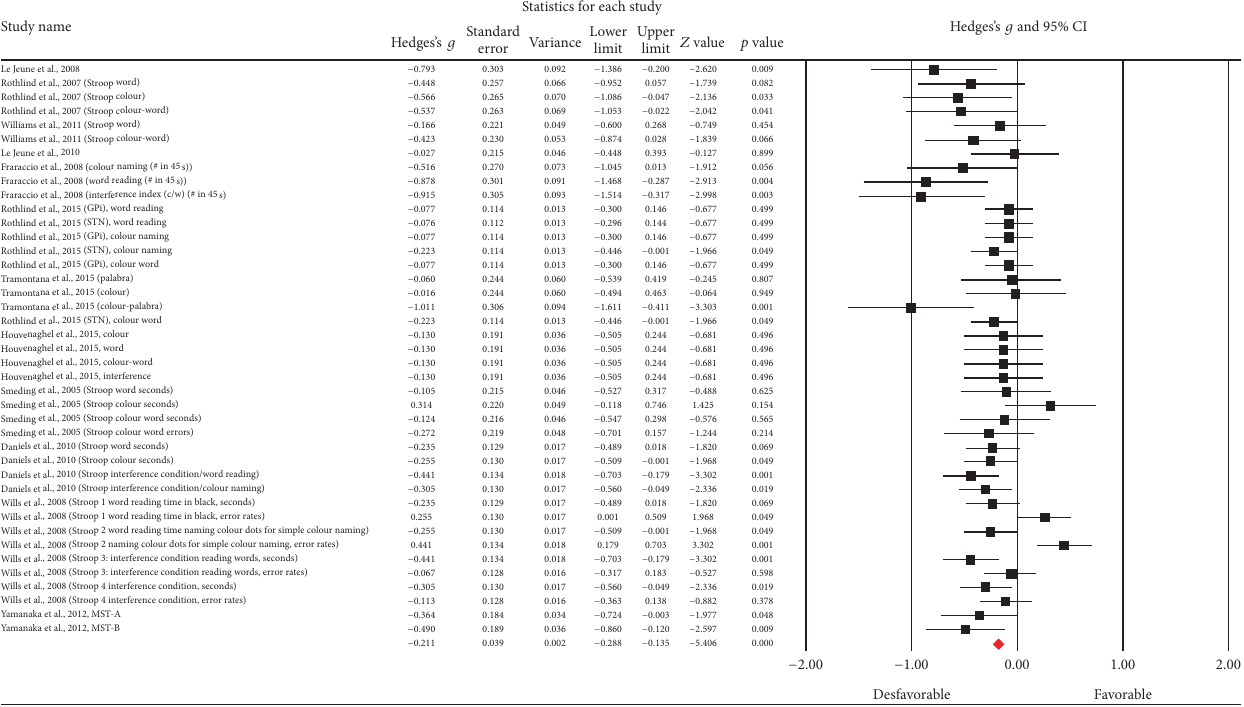
Figure 17: Meta-analysis of Stroop Test comparing before and after DBS